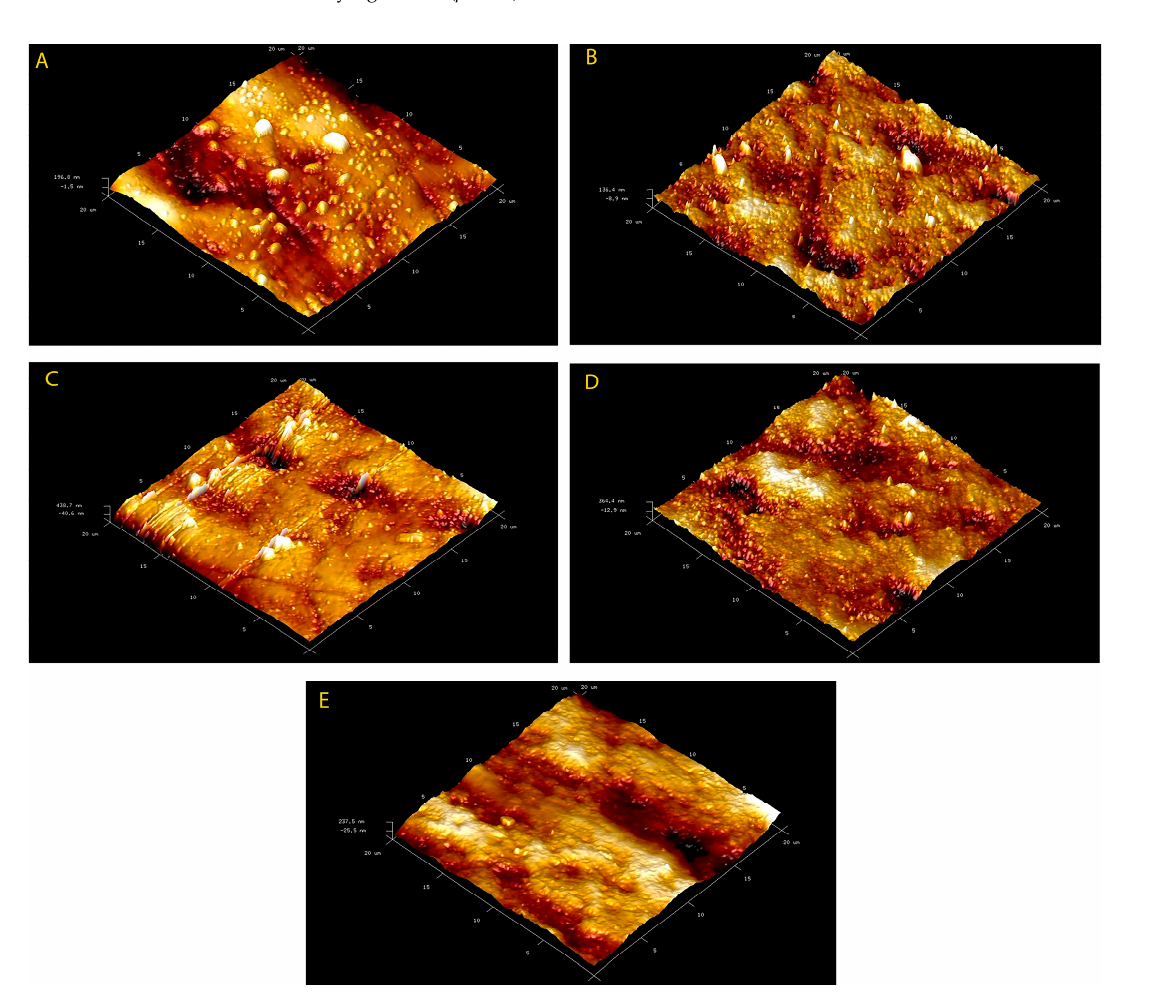
Figure 1. 3D topographic SPM images after 45 days. ( A ) Group 1: Bleached enamel surfaces treated with standard fluoridated toothpaste with bioglass (NovaMin). ( B ) Group 2: Bleached enamel surfaces treated with toothpaste containing calcium fluorosilicate glass (BioMIN). ( C ) Group 3: Bleached enamel surface treated with toothpaste containing stardard fluoride alone. ( D